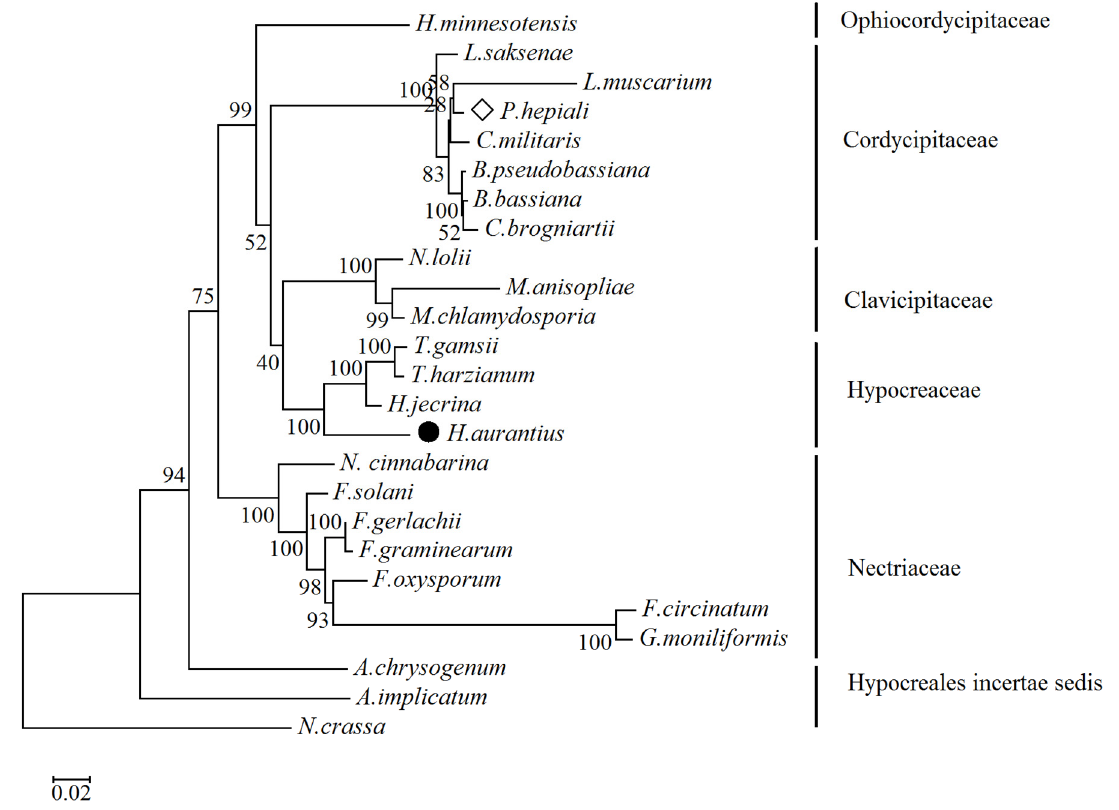
Figure 2. Phylogenetic tree of 24 mitochondrial proteomes in Hypocreales . A data set of 14 proteins was used, and topology was inferred using the Maximum Likelihood method (1000 replicates).